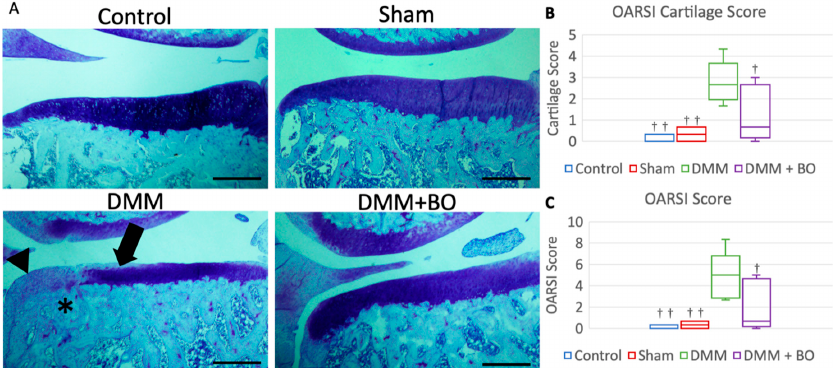
Figure 5. Histological analysis of the medial tibial cartilage. ( A ) Representative images of coronal sections of the medial tibial plateau stained with toluidine blue. Magnification: * 40. Scale bars = 500 µ m Arrow ( ➡ ) indicates degeneration of the extracellular matrix in articular cartilage. Asterisk (*) indicates subchondral bone damage. Arrowhead ( ▶ ) indicates osteophyte synthesis. ( B ) OARSI cartilage score. ( C ) Total OARSI score. Boxplots denote median values and interquartile ranges. Vertical bars show ranges ( n = 6 in the control and sham groups, n = 5 in the DMM and DMM + BO groups). The marks indicate a significant difference from the DMM group by the Tukey–Kramer test ( † p < 0.05, †† p < 0.01 vs. DMM).